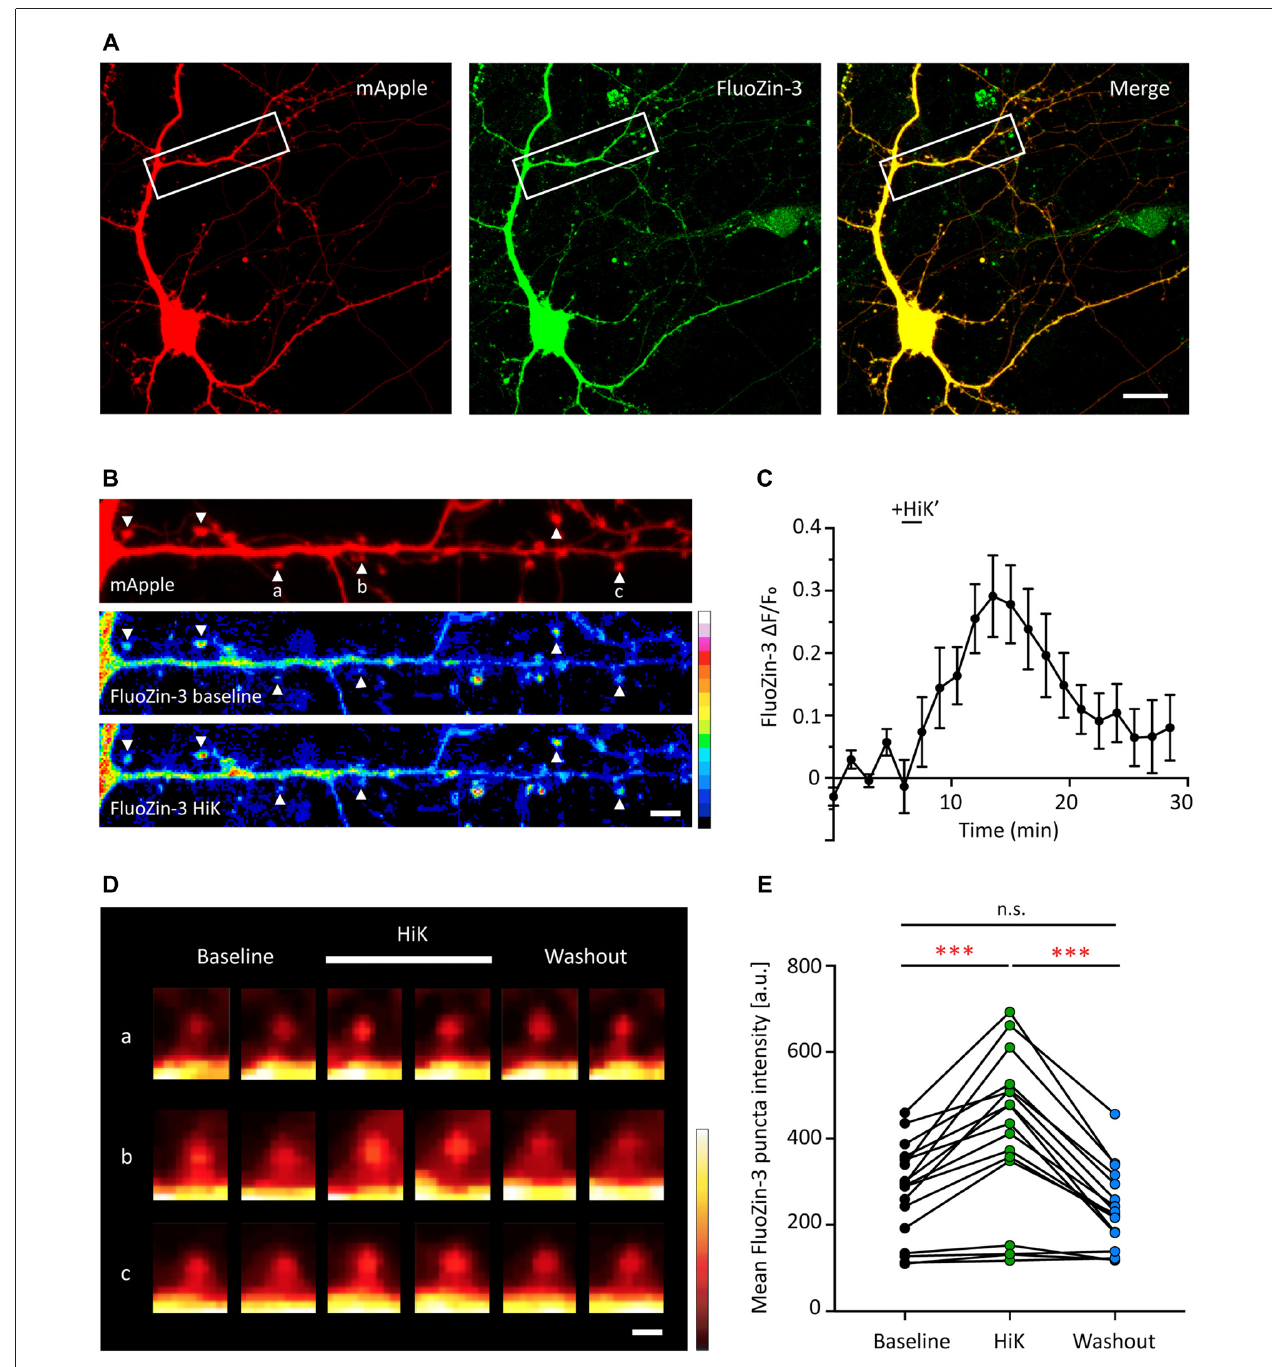
FIGURE 3 | Depolarization induces a transient and reversible increase of zinc in postsynaptic spines. (A) A young hippocampal neuron (DIV 14) transfected with mApple (left, red) and loaded with FluoZin-3 (middle, green). mApple was used as a morphological marker to indicate dendrites and postsynaptic spines. Yellow indicates clear colocalization in the merge image (far right). White boxes mark the dendrite shown in (B) . Scale bar: 10 µ m. (B) Straightened dendrite with mApple (top) and FluoZin-3 at baseline (middle) and during depolarization conditions [bottom; 90 mM KCl (HiK), 120–180 s]. White arrowheads mark spines being quantified in (C) and shown in ( D ; indicated by a–c). Scale bar: 5 µ m. (C) Time course of changes in FluoZin-3 ( ∆ F/F o ) with depolarization for spines in (B) . Black line indicates when depolarization was applied (HiK’). Mean ± SEM for N = 6 spines in one dendrite, shown in (B) . (D) FluoZin-3 fluorescence changes in individual spines (a–c) under baseline, HiK (white line) and washout conditions indicated in (B) . Scale bar: 1 µ m. (E) Effects of depolarization on FluoZin-3 in spines of individual hippocampal neurons averaged across baseline, during HiK and washout conditions (one-way ANOVA followed by Sidak’s multiple comparisons, N = 17 dendrites from five neurons from four culture preps, n.s. p > 0.05, ∗∗∗ p < 0.001).